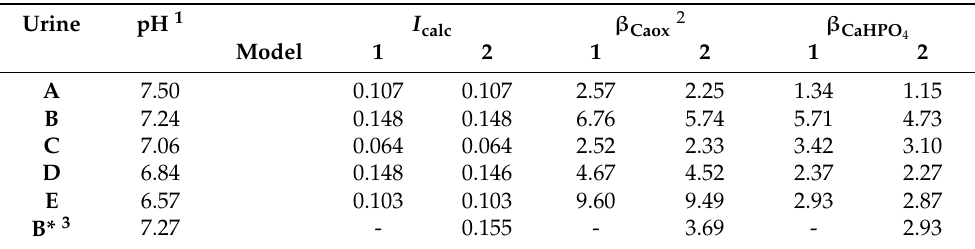
Table 2. Ionic strength ( I calc ) and saturation levels, estimated on five real urines. Model 1 does not consider the species [CaPO 4 ] − and [Ca(PO 4 )cit] 4 − . Model 2 considers the species [CaPO 4 ] −